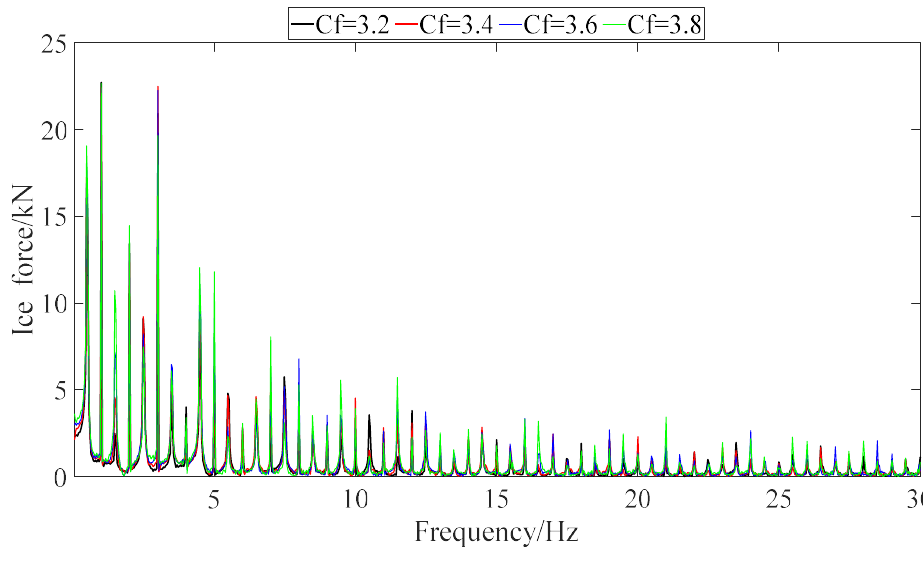
Figure 14. Frequency domain curves with different fracture coefficients ( C f ).